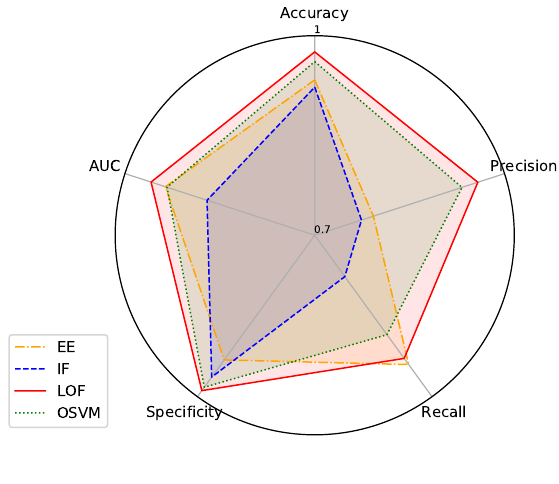
Figure 6. Mean results for accuracy, precision, recall, specificity and AUC considering all datasets with optimised